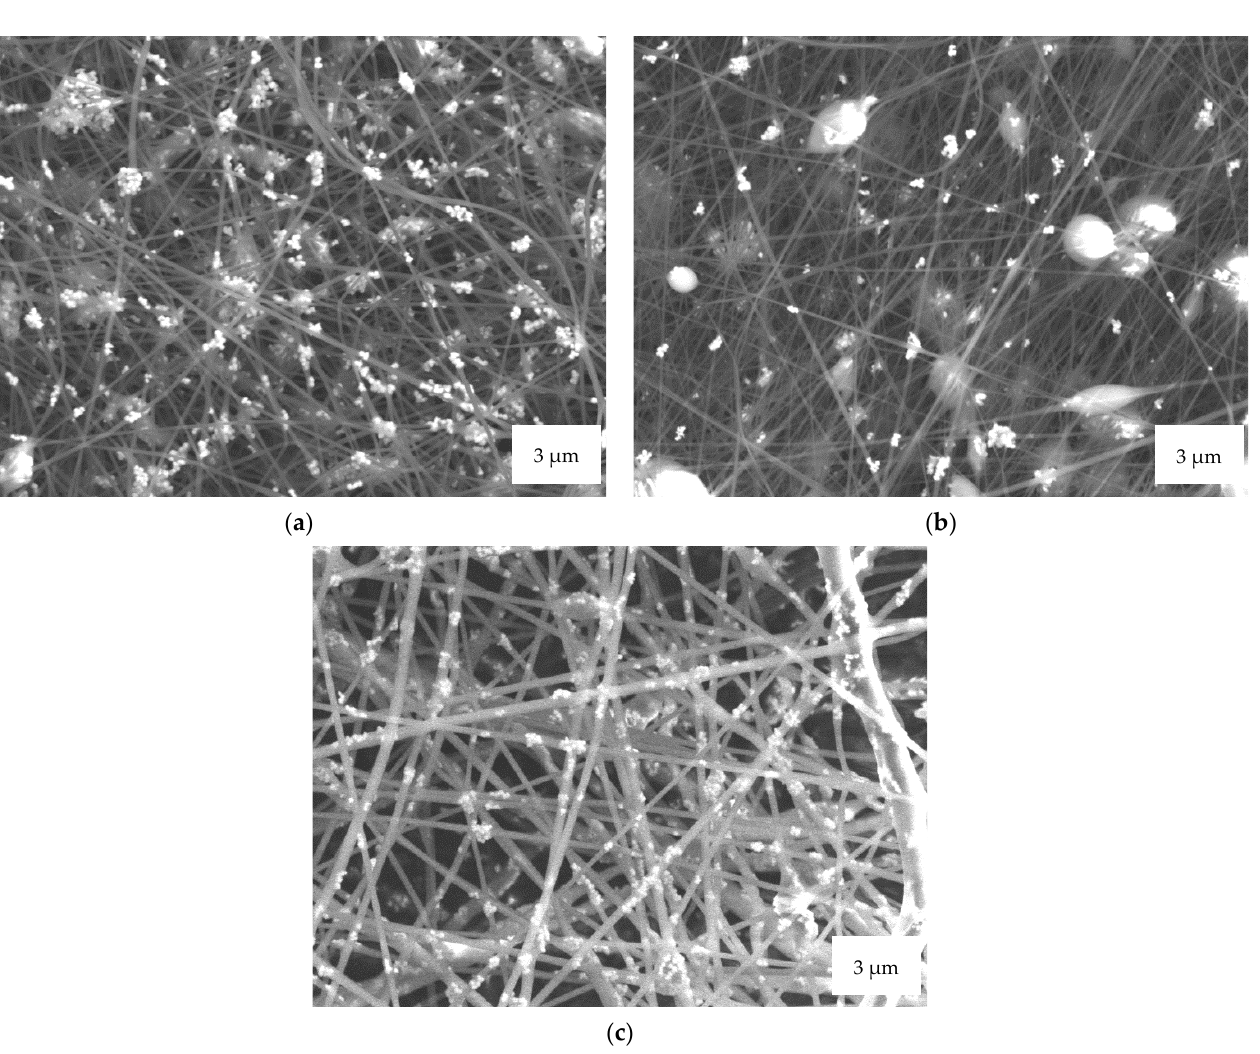
Figure 6. SEM micrographs of the magnetic nanofiber mats: ( a ) 16 wt% PAN with 65 kV voltage and 40 min ultrasonic bath; ( b ) 16wt% PAN with 80 kV voltage and 40 min ultrasonic bath; ( c ) 16 wt% PAN and 80 kV voltage without ultrasonic bath.